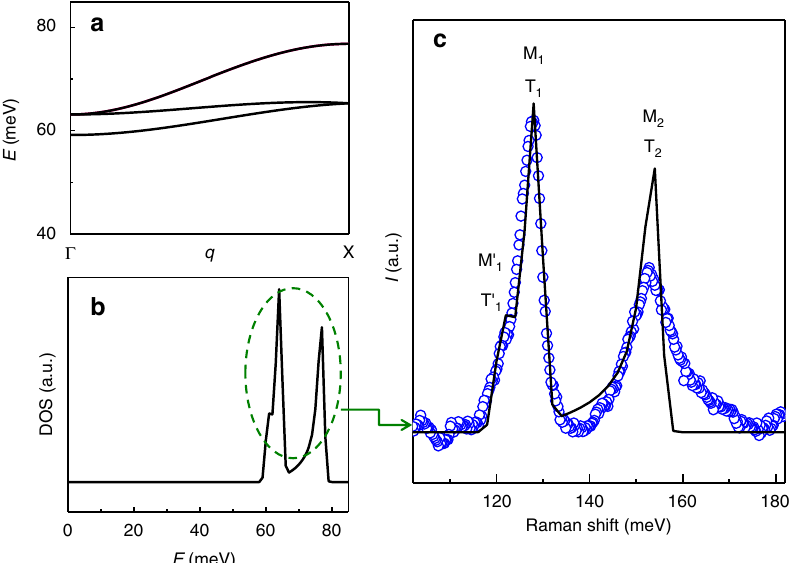
Fig. 3 LSWT calculations for Cd 2 Os 2 O 7 . a Spin wave dispersion showing three branches along the high symmetry Γ – X line for the AIAO ordered state. b Calculation of the magnon density of states DOS (a.u.). The spin wave and the magnon DOS are calculated with LSWT using values of J = 5.1 meV, D = 1.7 meV, A = − 5.3 meV. c Comparison between the experimental spectrum of the two-magnon Raman scattering at 100 K ( open blue circles ) and the theoretical magnon DOS with energy scaled by factor of two ( black solid line ). The comparison con fi rms that the broad Raman peaks arise from two- magnon Raman scattering in the AIAO state, likely involving the two highest energy magnon branches at the X